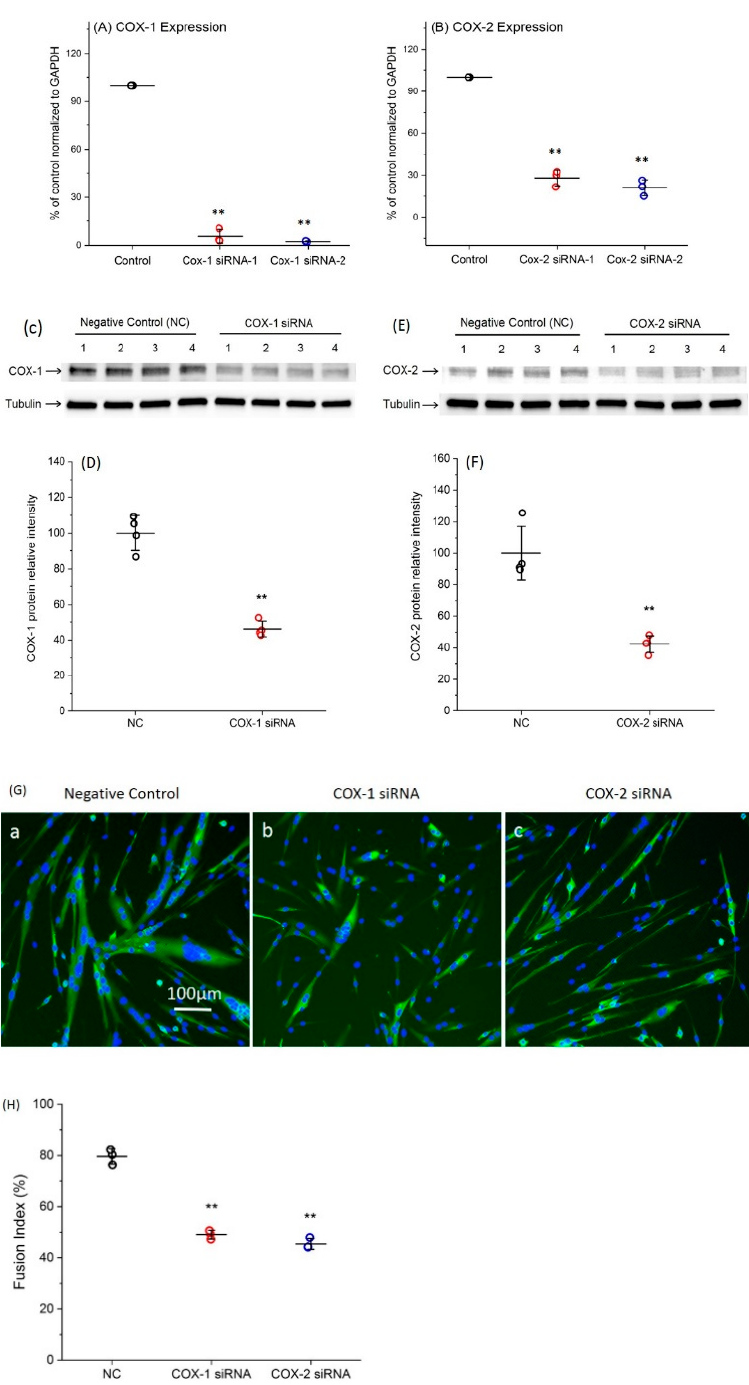
Figure 1. Verification of the high e ffi ciency of COX-1 and COX-2 siRNA knockdown. ( A ) Knockdown e ffi ciency of siRNAs targeting COX-1; ( B ) knockdown e ffi ciency of siRNAs targeting COX-2; ( C ) COX-1 Western blot results after siRNA transfection for 48 h; ( D ) quantification of COX-1 Western blot results using ImageJ; ( E ) COX-2 Western blot results after siRNA transfection for 48 h; ( F ) quantification of COX-2 Western blot results using ImageJ; and ( G ) both COX-1 and COX-2 siRNA transfections inhibit primary myoblast myogenic di ff erentiation. Morphological phenotypes observed after transfections with siRNAs. a: Negative control; b: COX-1 siRNA; and c: COX-2 siRNA. ( H ) Treatments with siRNAs significantly reduces fusion index. n = 3–4, ** p < 0.01 compared with NC.